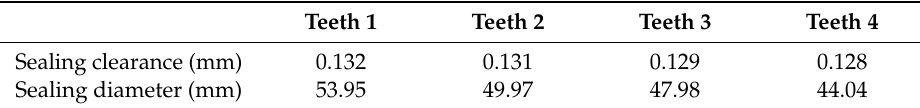
Table 8. The measured results of the sealing structure.